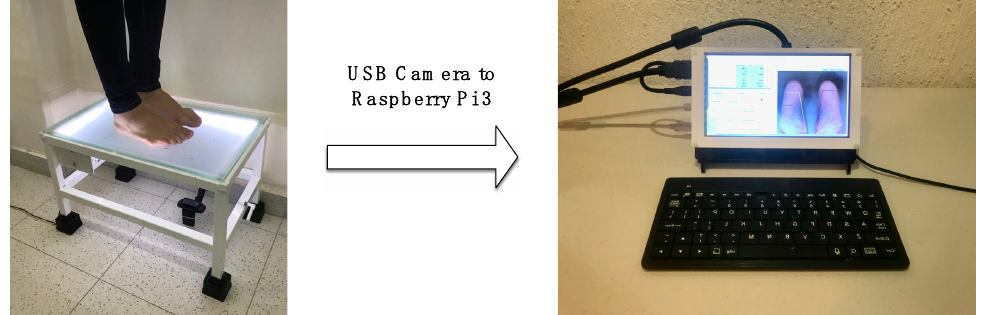
Figure 2. Adaptation of the original podoscope placing a frosted film on the top and the camera connected to the Raspberry Pi 3 via USB. Using an USB camera, the Raspberry Pi 3 acquires an image of the patient’s footprints ( left ) and process it to display the results in the graphical user interface ( right ).